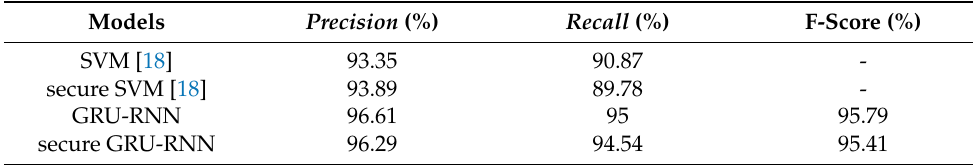
Table 4. Parameter comparison of the HDD